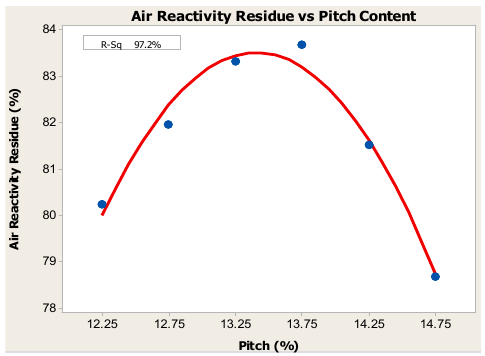
Figure 7. Air reactivity residue (RR) vs. pitch content.